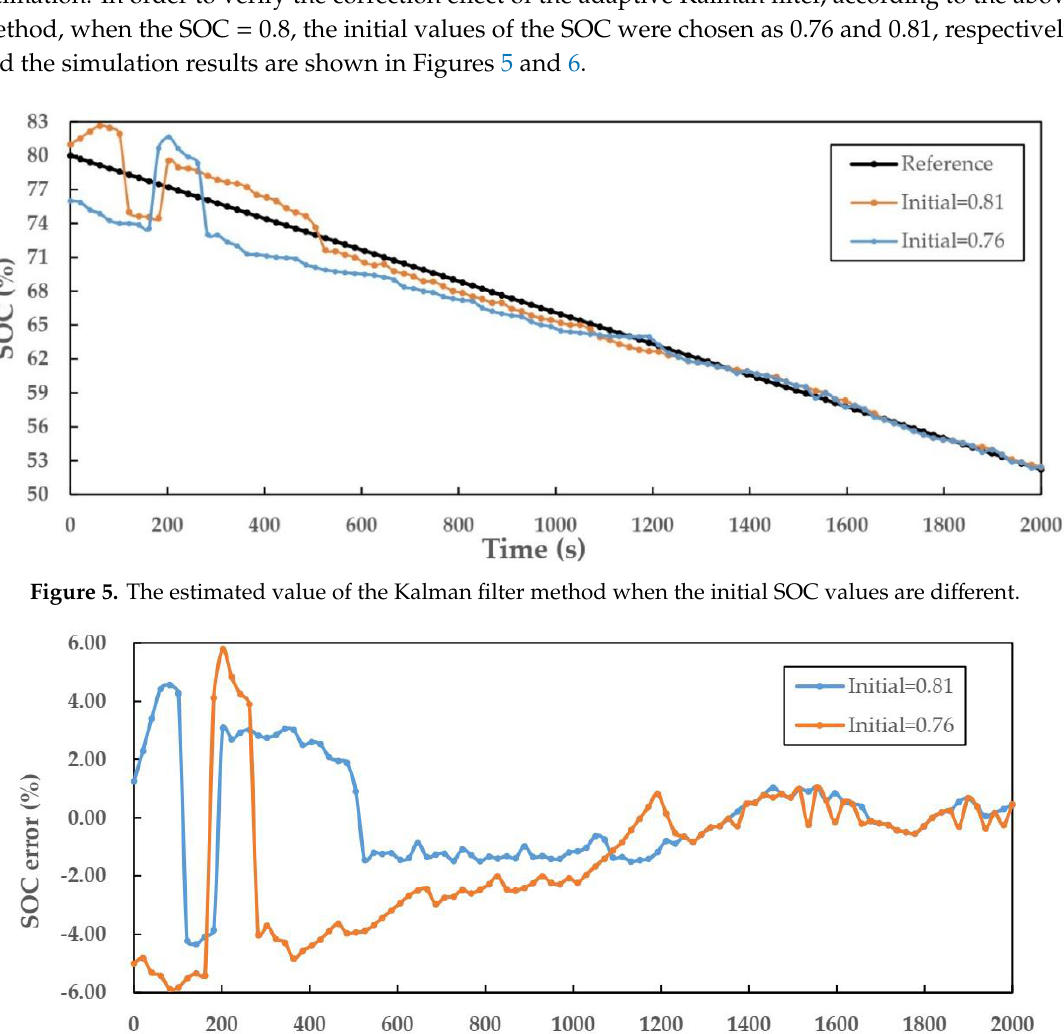
Figure 6. The estimated value error of the Kalman filter method when the initial SOC values are different.